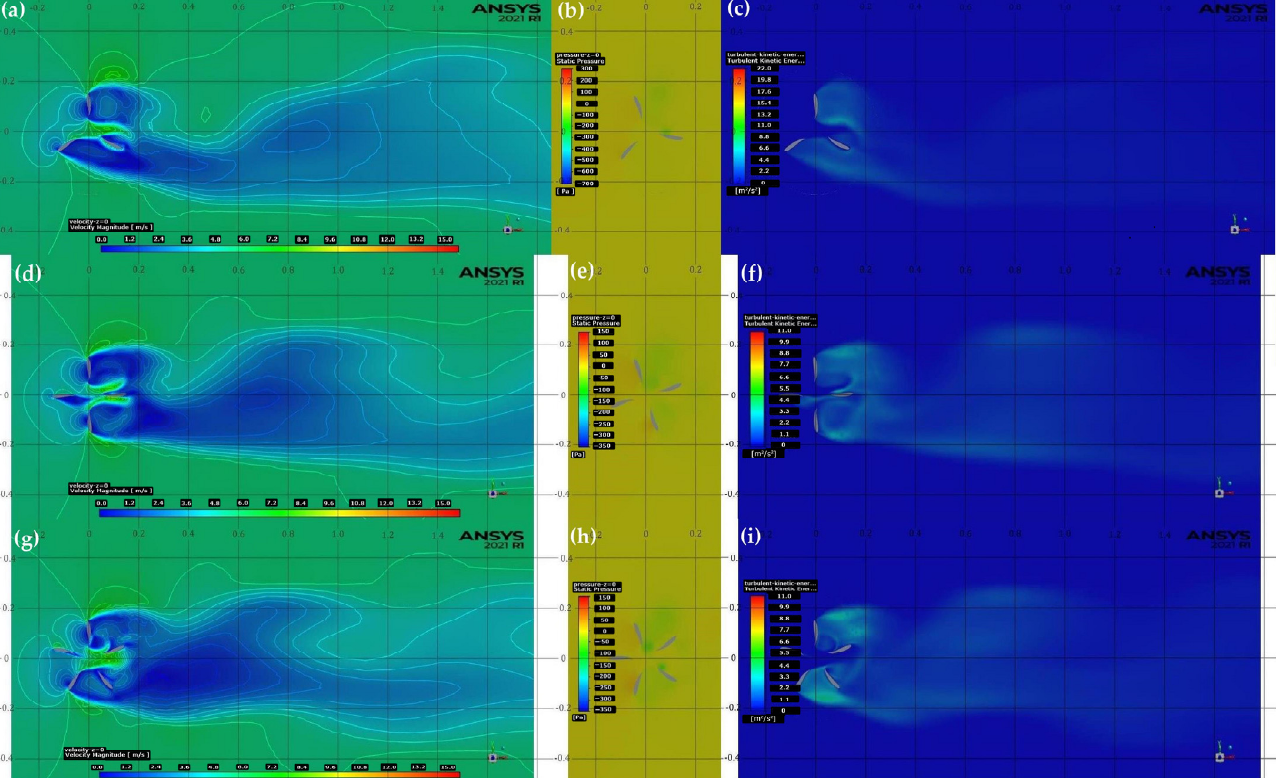
Figure 18. Contours at wind speed 6 m/s, TSR 0.1, for Savonius with varied number of blades: ( a ) Velocity with 3 blades; ( b ) Pressure with 3 blades; ( c ) TKE with 3 blades; ( d ) Velocity with 4 blades; ( e ) Pressure with 4 blades; ( f ) TKE with 4 blades; ( g ) Velocity with 5 blades; ( h ) Pressure with 5 blades; ( i ) TKE with 5 blades.